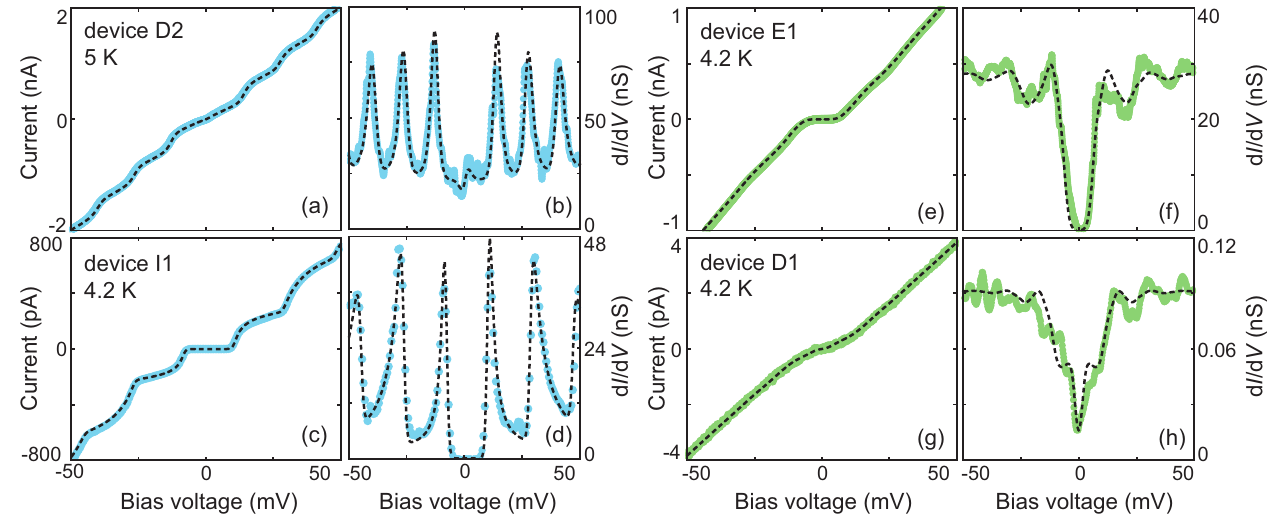
Figure 2. Experimental current − voltage ( IV ) characteristics (colored dots) and the corresponding calculated curves using the orthodox Coulomb blockade model (black dashed lines) acquired on four devices, displaying clear step-like features (light blue dots) or a single transport gap centered around zero bias (green dots). ( a , e , g ) Experimental IV s measured on, respectively, device D2, E1, and D1; obtained by sweeping the voltage from positive to negative values. ( c ) IV measured on device I1, obtained by sweeping the voltage from negative to positive values. The corresponding differential conductance is depicted in figures ( b , d , f , h ). The data were recorded at either 4.2 or 5.0 K. The parameters used for the simulations are presented in Table 1. Table 1. Coulomb-blockade simulation parameters used to generate the four simulated IV s depicted in Figure 2. C 1 and C 2 are the junction capacitances on the left and right sides, respectively. R 1 and R 2 are the tunnel resistances on the left and right sides, respectively. Q 0 is the offset charge, and T is the temperature.